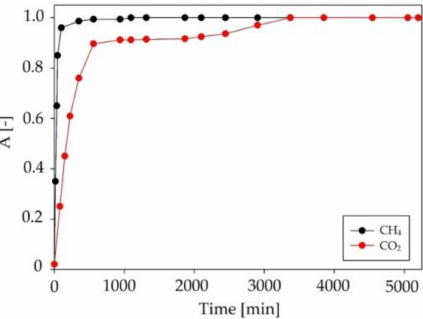
Figure 11. Absorption curves for methane and carbon dioxide in C:DA (1:1).